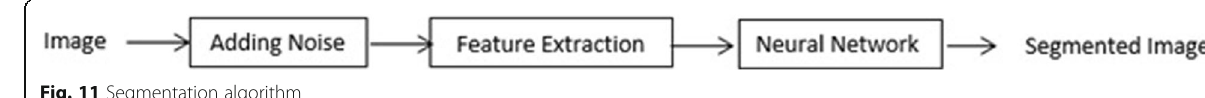
Fig. 11 Segmentation algorithm